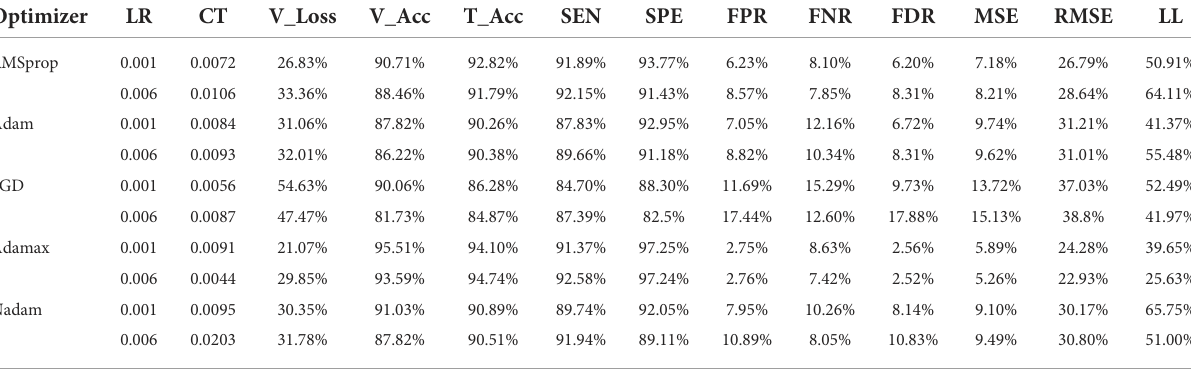
TABLE 8 A detailed comparison of testing accuracies among all the optimizers with different learning rates, comparison of the optimizers, and optimistic outcomes of various optimizers on the HAM10000 dataset. Optimizer LR RMSprop